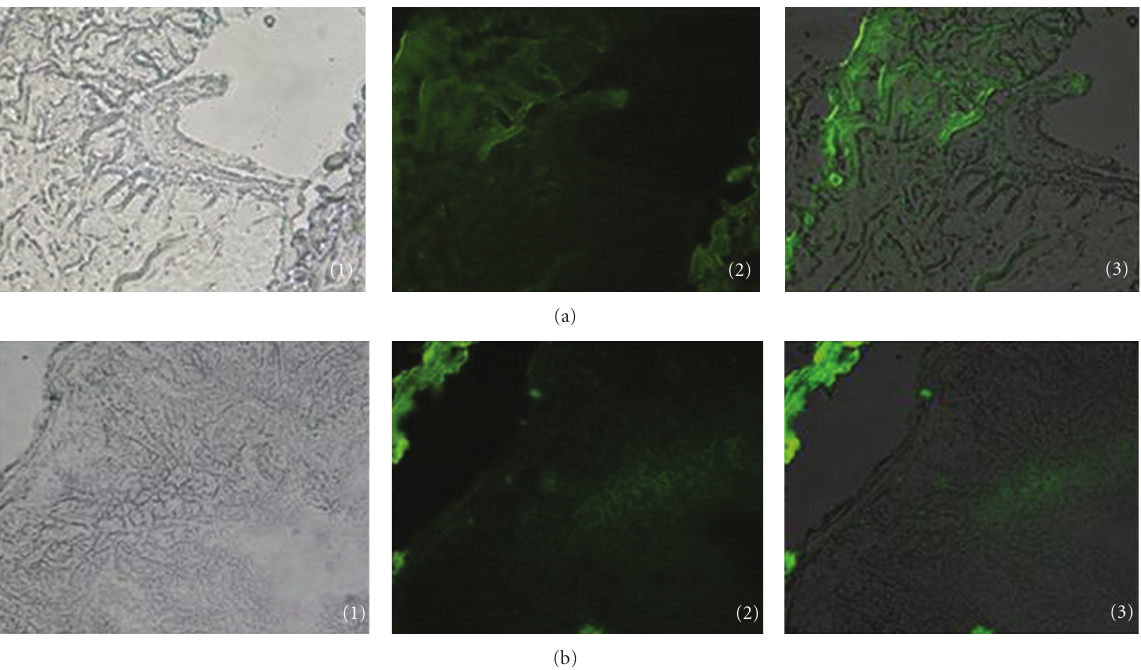
Figure 6: Intestinal mucosal binding assay. Images of the NOD mice frozen gut sections of (a)NOD mice fed CTB-GFP and (b) NOD mice fed CTB-Ins-GFP. Gut sections under (1) normal light, (2) blue light, and (3) overlapped. Magnification is 40x.